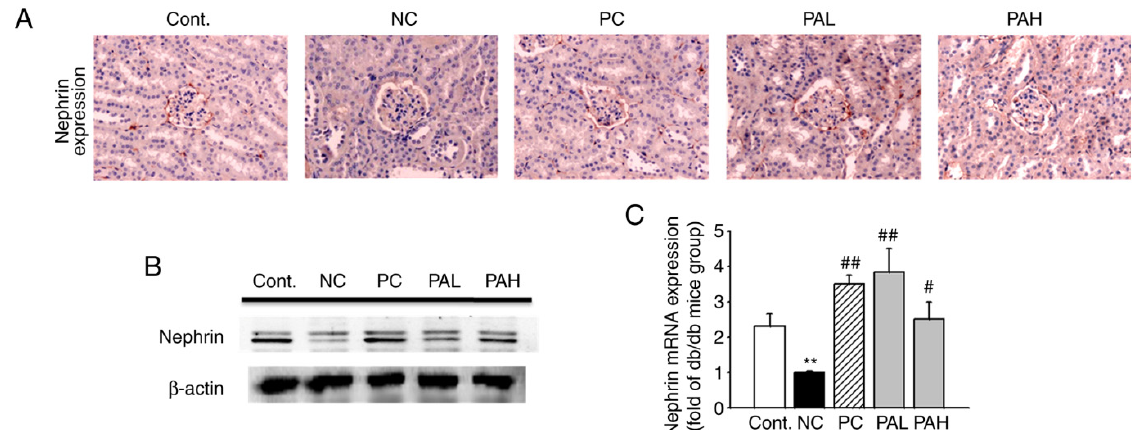
Figure 5. Effect of ER-PA on nephrin immunoreactivity in db/db mice. Expression of nephrin in kidneys was determined with ( A ) immunohistochemistry staining, ( B ) western blotting and ( C ) reverse transcription-quantitative PCR analysis. Values are expressed as mean ± standard error of the mean ( n = 8). ** p < 0.01 vs. db/m; # p < 0.05, ## p < 0.01 vs. db/db ( n ≥ 3; magnification, ×200). PA, Polygoni avicularis ; AG, db/db mice daily treated with 20 mg/kg aminoguanidine; PAL, db/db mice daily treated with a low concentration (10 mg/kg) of ER-PA; PAH, db/db mice treated daily with a high concentration (50 mg/kg) of ER-PA.